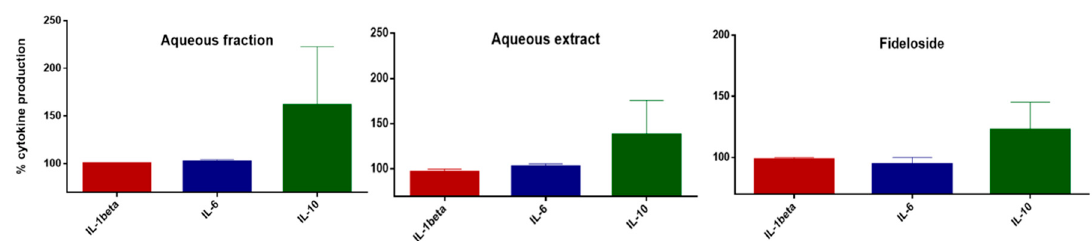
Figure 5. Anti-inflammatory capacity of extracts (3 µg/mL) and isolated Fideloside (1 µM) from Phyllanthus orbicularis . Levels of pro- and anti-inflammatory cytokines after poly-IC stimuli (CTRL+, 100%) of human monocytes.